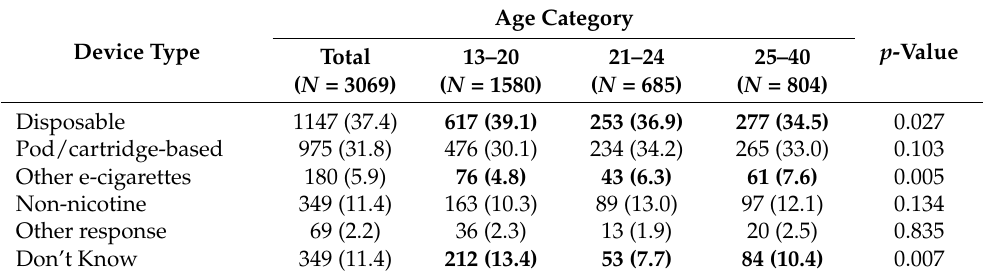
Table 2. Most used device type among ever users of e-cigarettes by age category, no. (%).